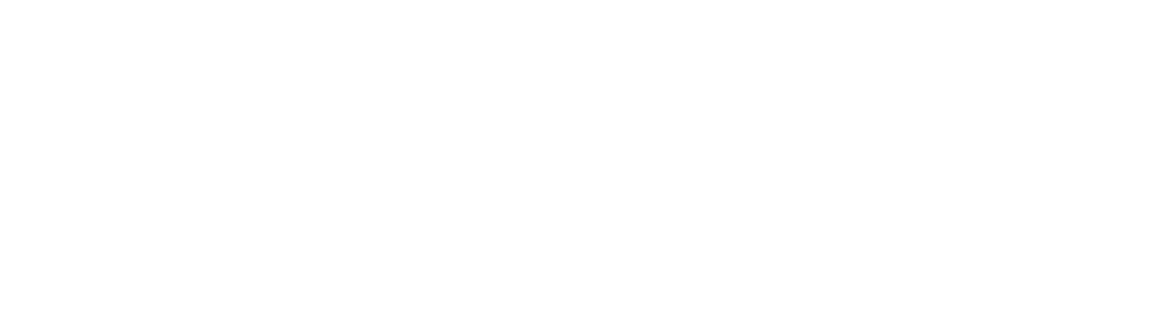
Table 1 Clinical literature review of parathyroid carcinoma in children under 16 Year Sex Age Ca, mg/dL i-PTH, pg/mL Symptoms Family history Palpable neck